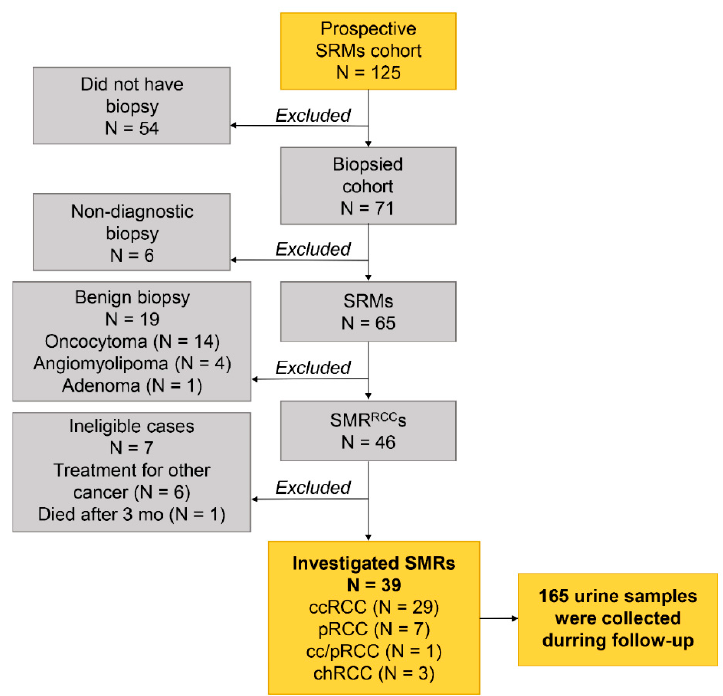
Figure 4. Consort diagram of the patients with SRMs managed by active surveillance. SRM—small renal mass; RCC—renal cell carcinoma; ccRCC—clear cell RCC; pRCC—papillary RCC; chRCC— chromophobe RCC;